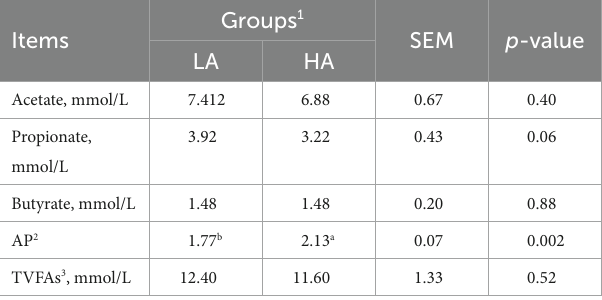
TABLE 1 Fecal-sample fermentation parameters at Sanhe heifers from different altitudes.